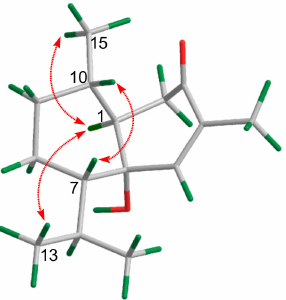
Figure 3. Key NOE correlations of 1 .